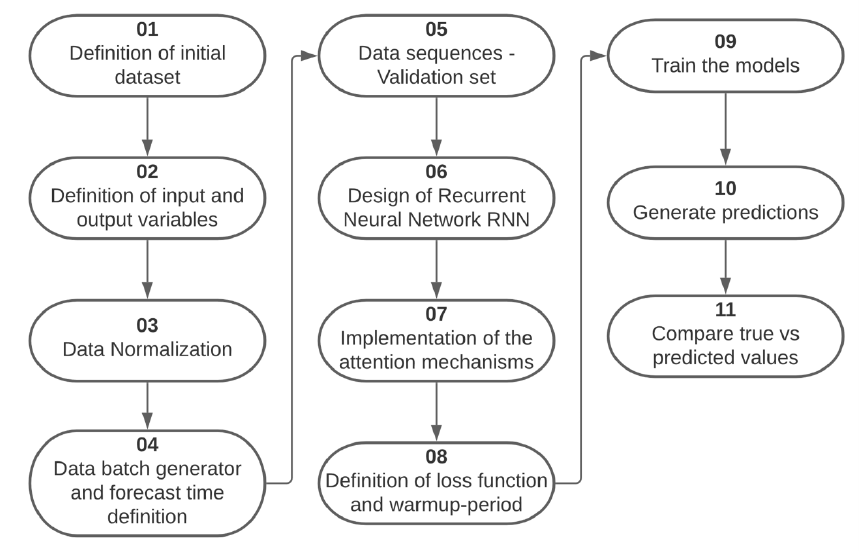
Figure 5. Step by step development of the temperature prediction model.